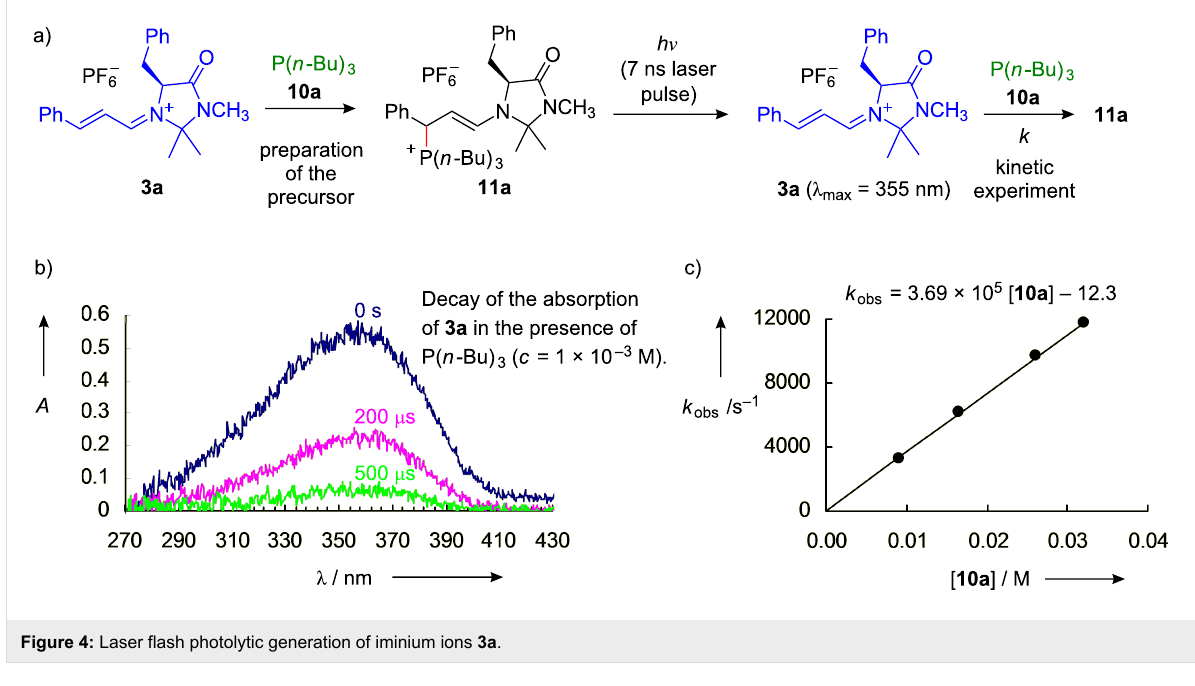
of the plots of the first-order rate constants k obs versus the concentrations of the corresponding nucleophiles (Figure 4c).